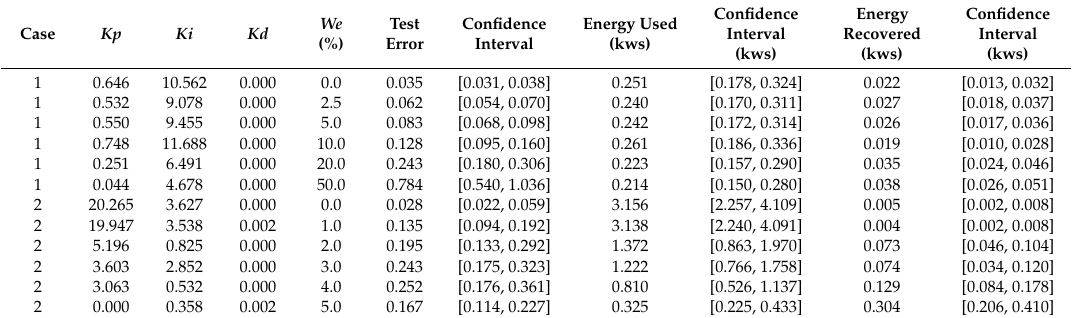
Table 5. Results of the optimization tests for the two selected cases using bootstrap. Case Ki Kd